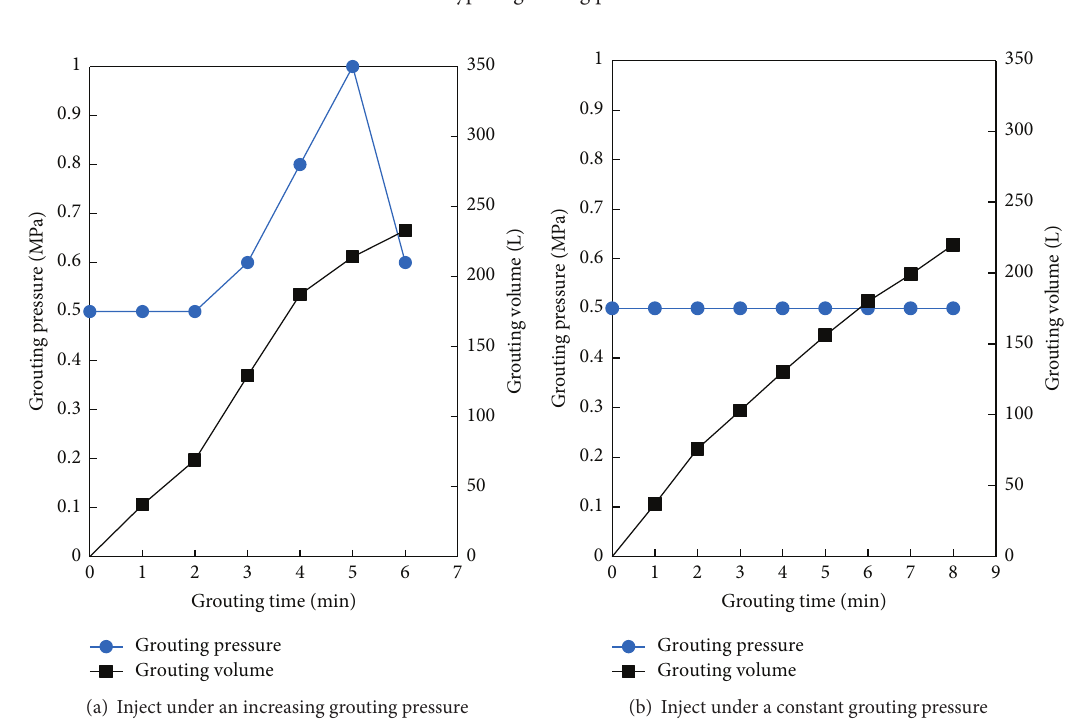
Figure 11: The typical grouting process of C2 and